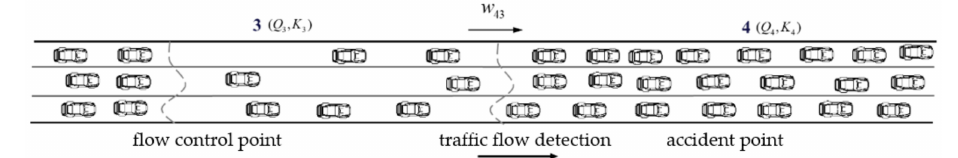
Figure 10. Diagram of flow density after traffic flow cleared by accident meets the saturated traffic flow in the extra-long tunnel.